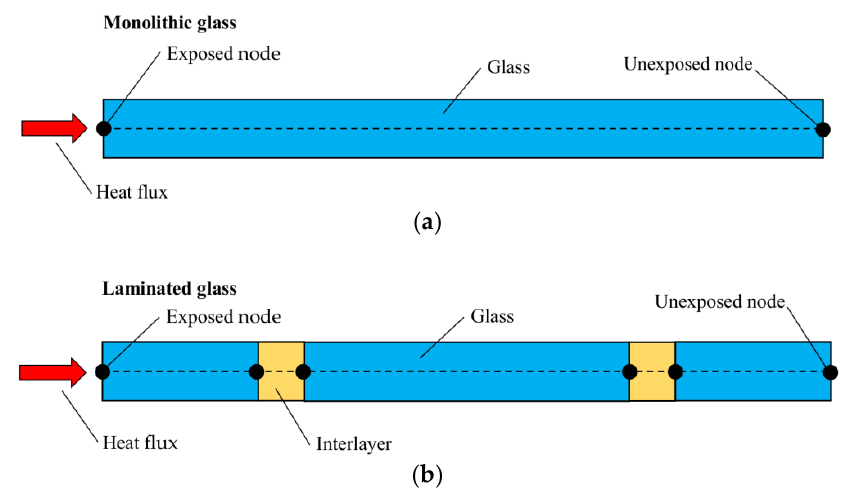
Figure 5. Schematic representation of the reference 1D heat transfer model for ( a ) monolithic and ( b ) laminated glass specimens (ABAQUS).